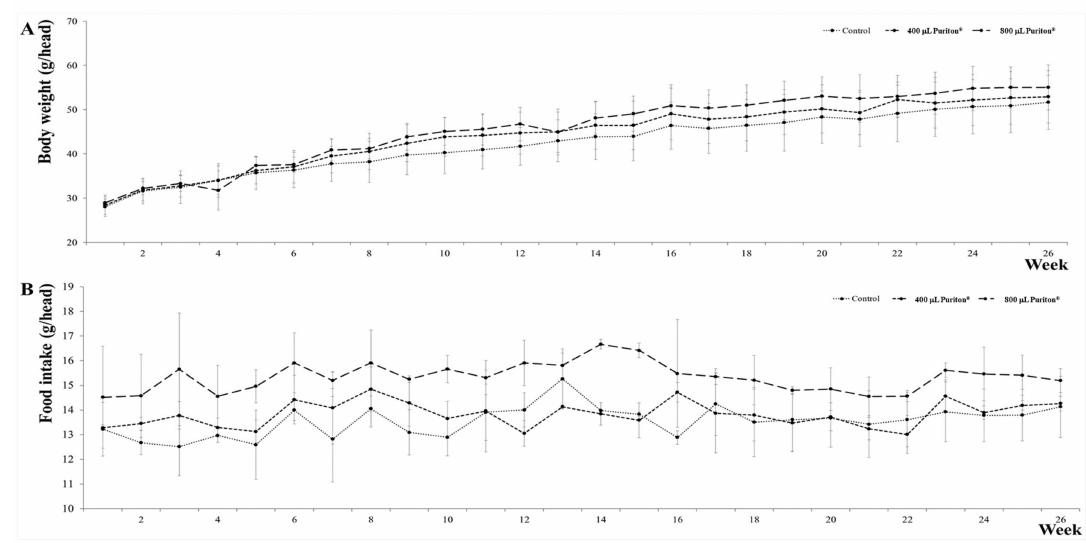
Figure 2. Changes in body weight and food intake per week of 26-week treatment. The dots represent the mean and SD. ( A ) Body weight changes during the study; ( B ) Food intake changes during the study.